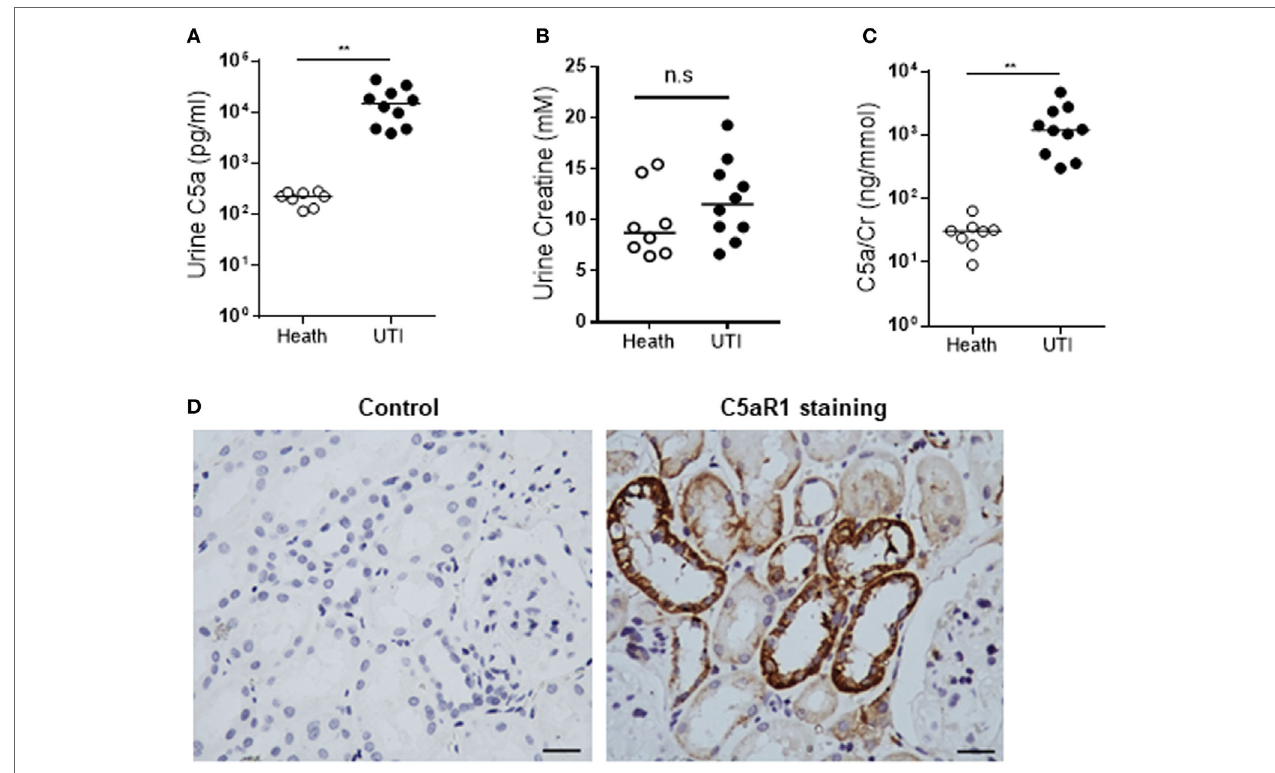
FigUre 7 | Detection of C5a and C5aR1 in human urinary tract. (a–c) C5a and creatinine concentrations in urine from urinary tract infection (UTI) patients and healthy controls. (a) Urinary C5a concentrations. (B) Urinary creatinine concentrations. (c) Ratios of urinary C5a/creatinine concentration. Data were analyzed by Mann–Whitney U two-tailed test. ** P < 0.01, n.s. no significant. (D) C5aR1 expression in human kidney tissue determined by immunochemical staining. Control: negative control, tissue stained with non-specific mouse IgG2a. Scale bar, 50